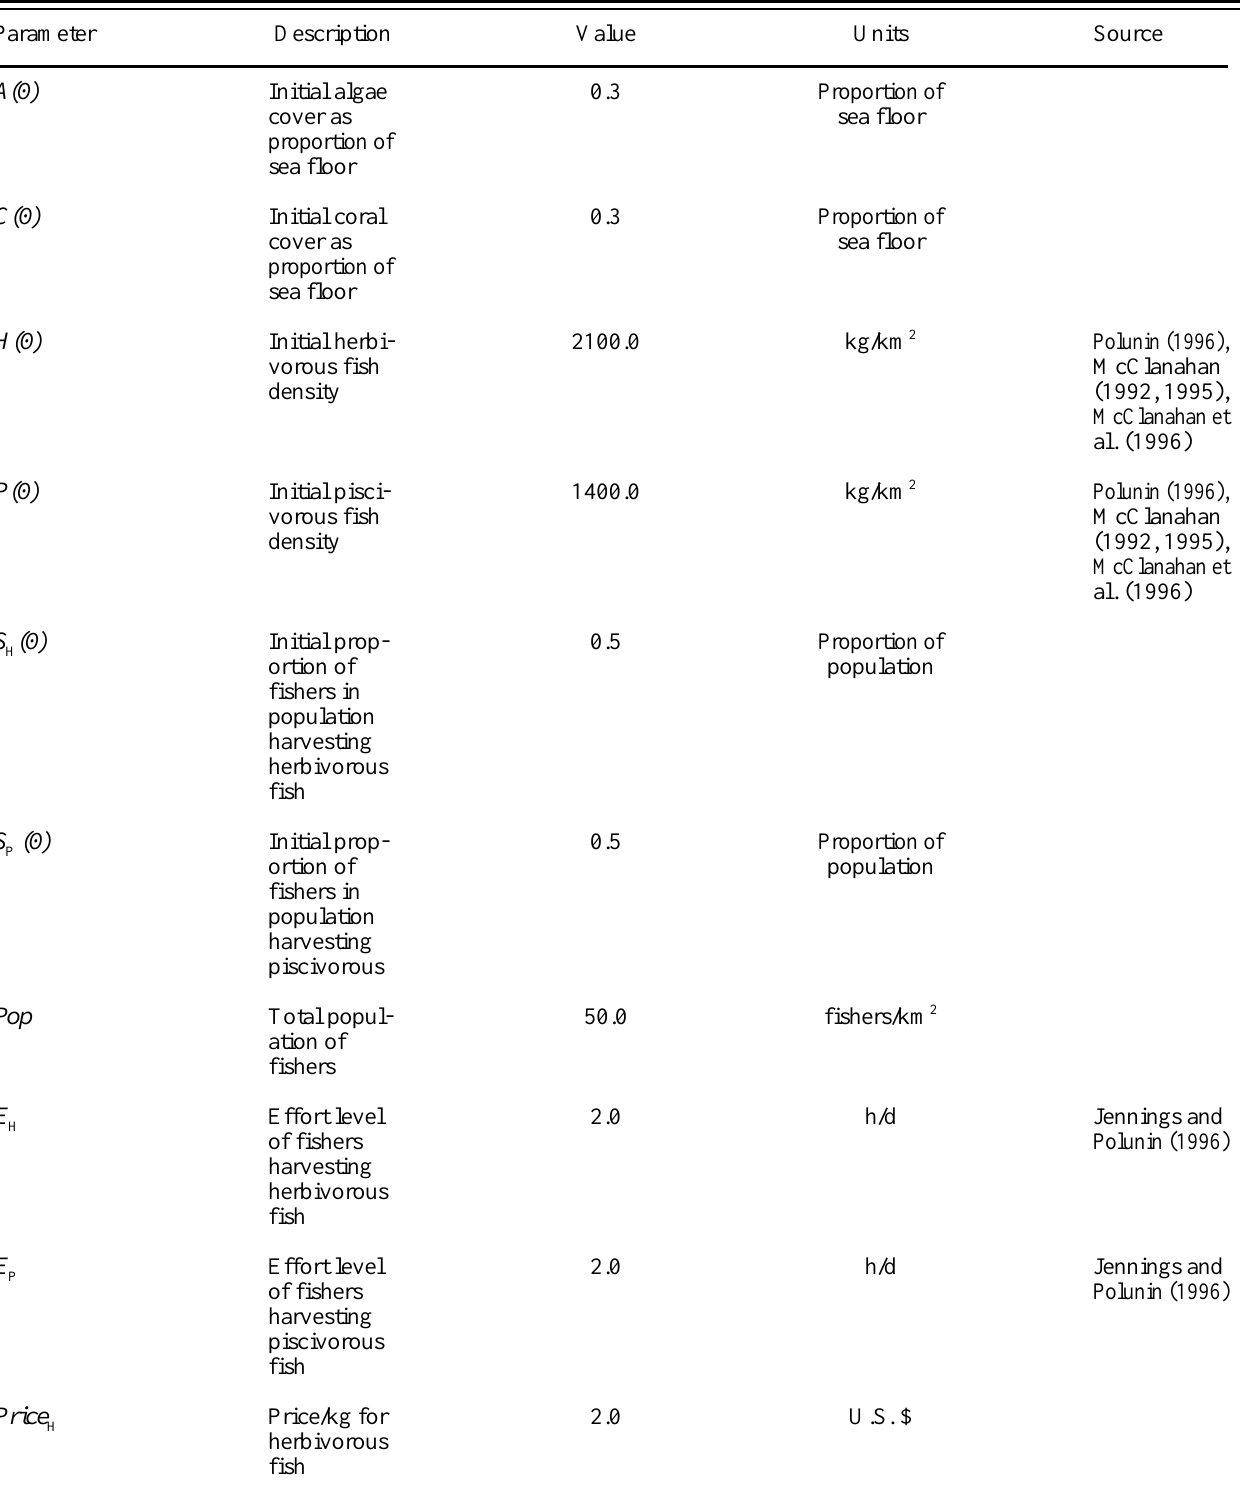
Table 2 . Derived parameter values used in baseline